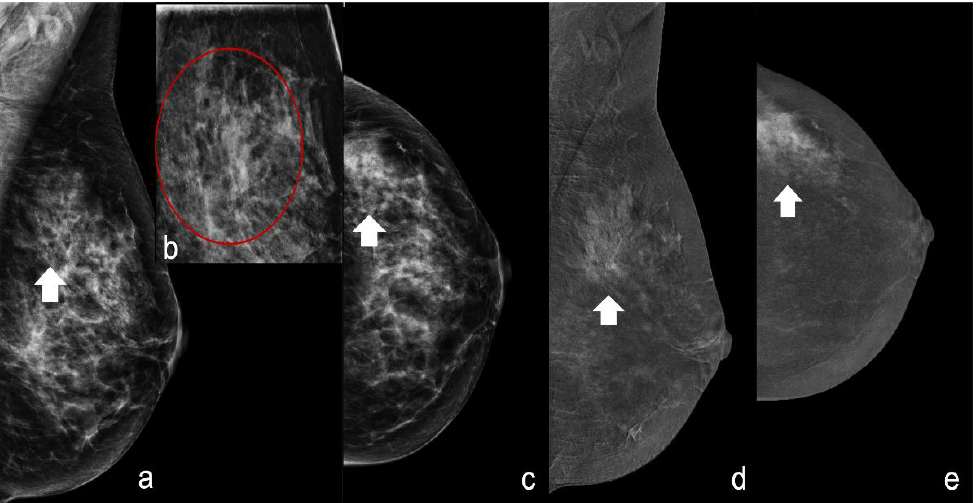
Figure 2. A 45-year-old patient with an extended segmental area of microcalcifications of the upper quadrants of the left breast. ( a – c ) Craniocaudal (CC) and mediolateral oblique (MLO) view and magnification of the upper quadrant of the left breast showing suspicious polymorphic microcalcifications (white arrowheads red circle). ( d , e ) CESM recombine images (CC and MLO view) showing a marked enhancement (score 3) at the site of suspicious microcalcifications (white arrowheads). Histology was high-grade invasive ductal carcinoma.